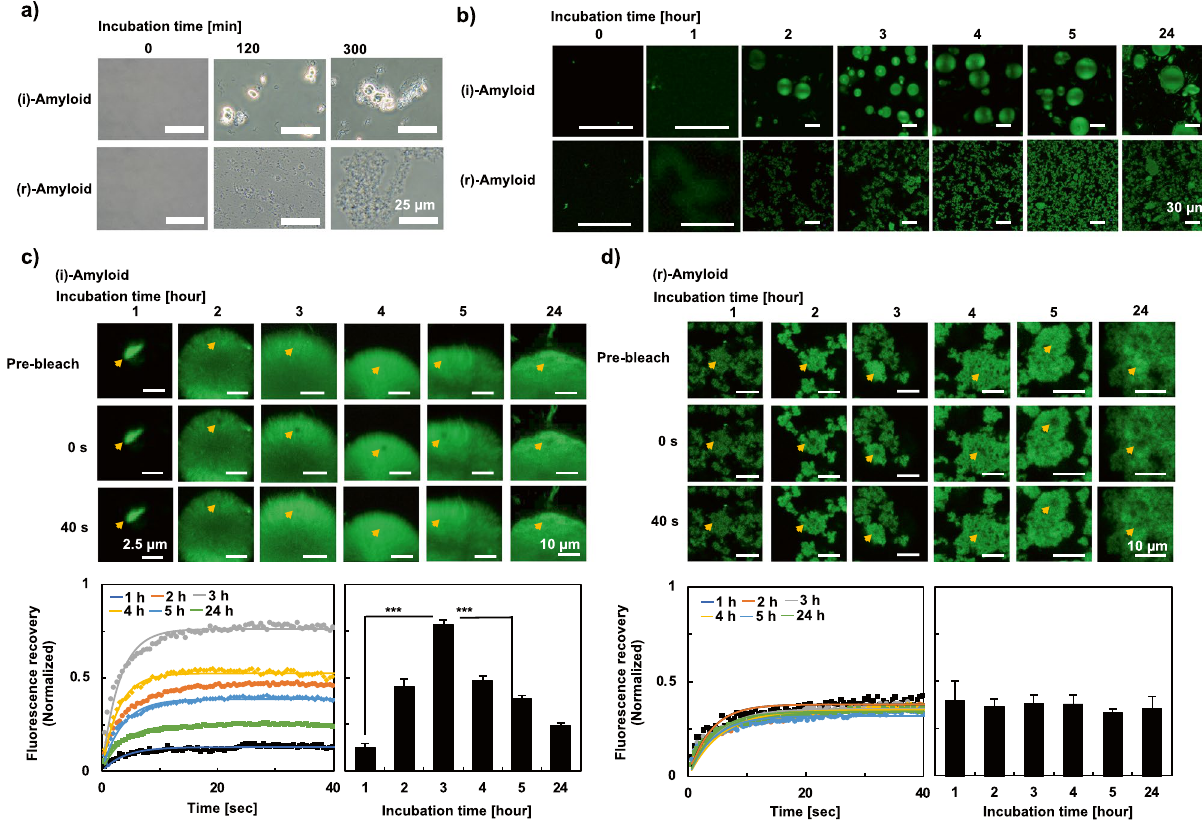
Figure 1. Morphology observation and evaluation of the liquidity of insulin amyloids. ( a ) Images of insulin amyloids were observed using an optical microscope. Insulin monomer was incubated for the indicated periods ((i)-amyloids, upper; (r)-amyloids, lower). ( b ) Fluorescence images showing the growth of droplets. ( c and d ) A representative spot at the indicated time points (upper) and FRAP measurements of insulin (i)-amyloids ( c ) and (r)-amyloids ( d ) to measure the change in fluorescence recovery (1 h (black), 2 h (red), 3 h (blue), 4 h (green) 5 h (orange), and 24 h (cyan) (lower left)) using the NIS-Elements (Ver. 5.21, Nikon) software. The intensities were normalized to the fluorescence intensity before bleaching. The orange arrows represent bleaching area. The lower right panels are the plots of normalized intensities before bleaching. Data represent the mean ± s.e.m. for 5 independent experiments. ***P < 0.005 (two-tailed Student’s t